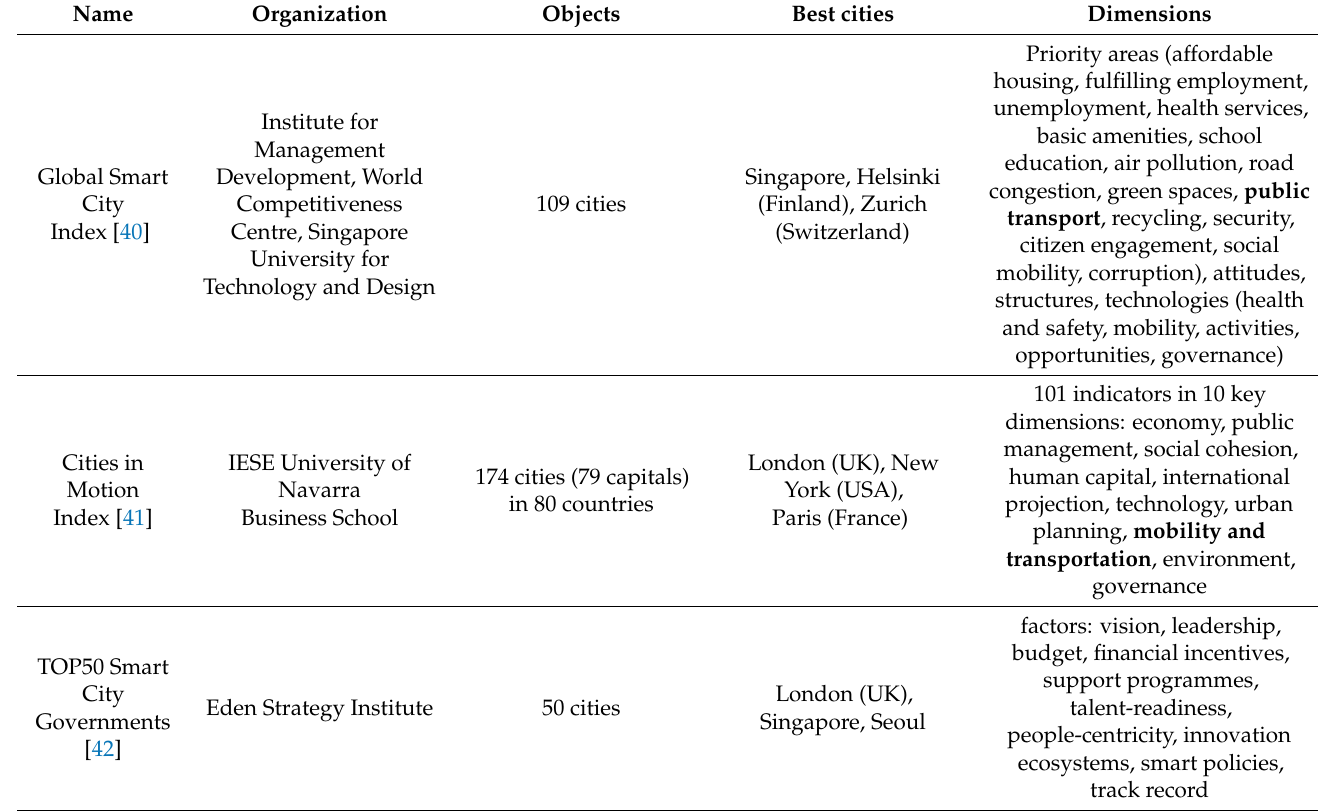
Table 2. The characteristics of the most popular smart city